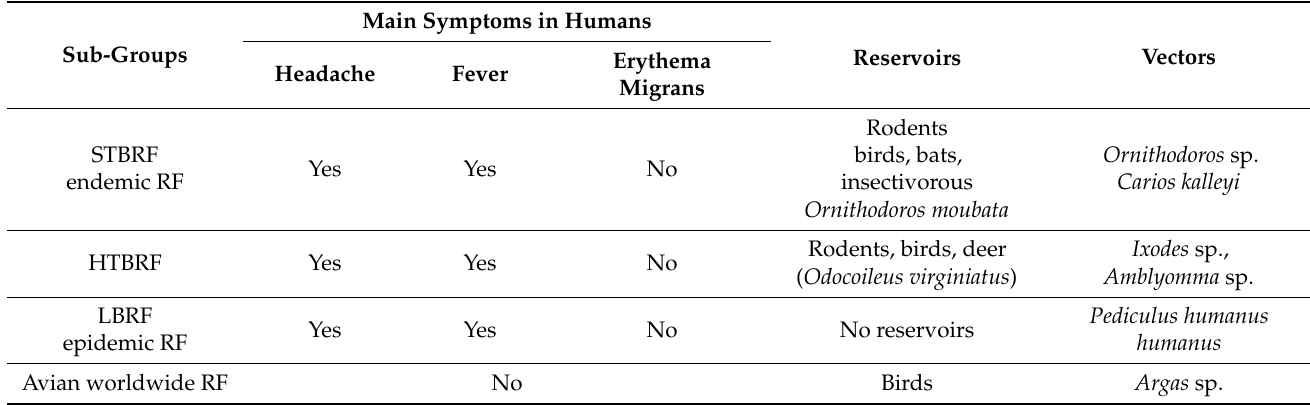
Table 1. Borreliae of relapsing fever group subgroupings according to symptoms, reservoirs, and vectors.